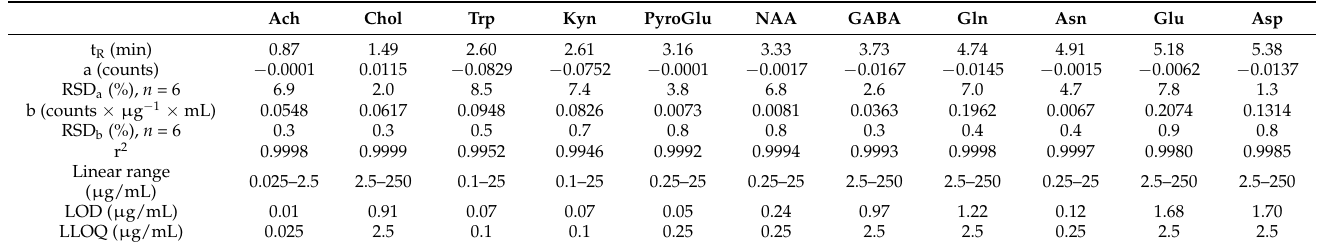
Table 2. Selected operation and validation parameters of the LC-MS/MS method.